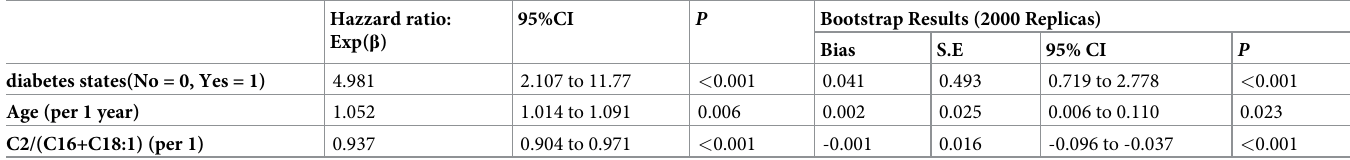
Table 4. Multivariable Cox regression analysis for the correlates of mortality by forward stepwise method and bootstrap